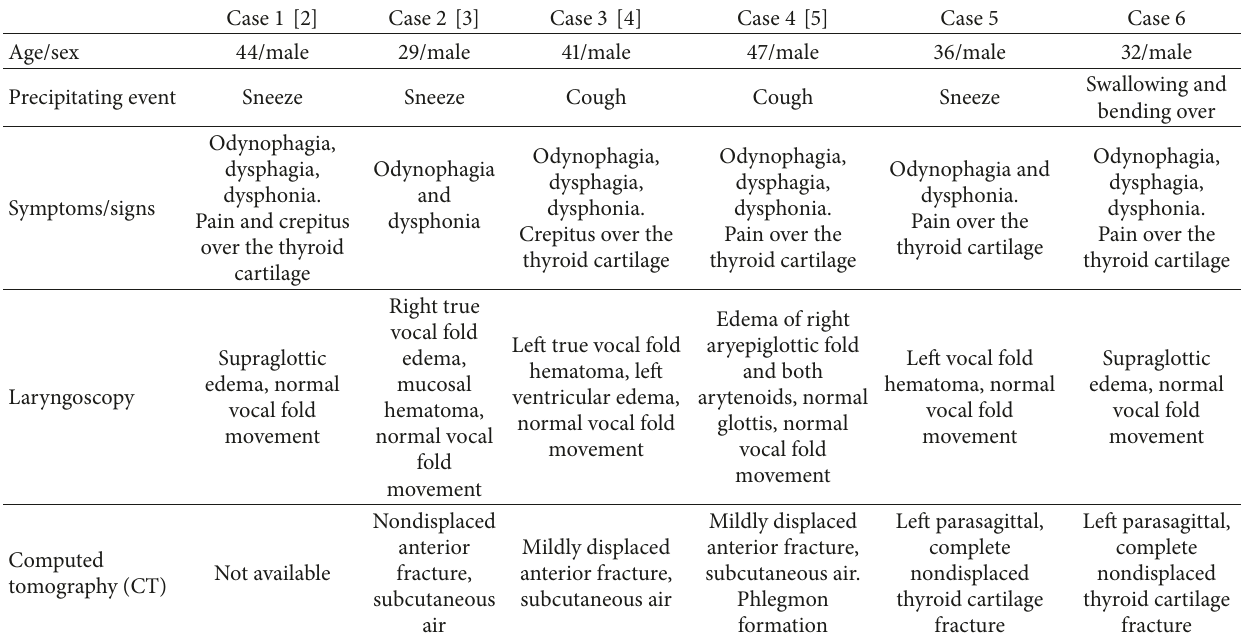
Table 1: Symptoms, signs, and endoscopic and imaging findings among patients with nontraumatic laryngeal